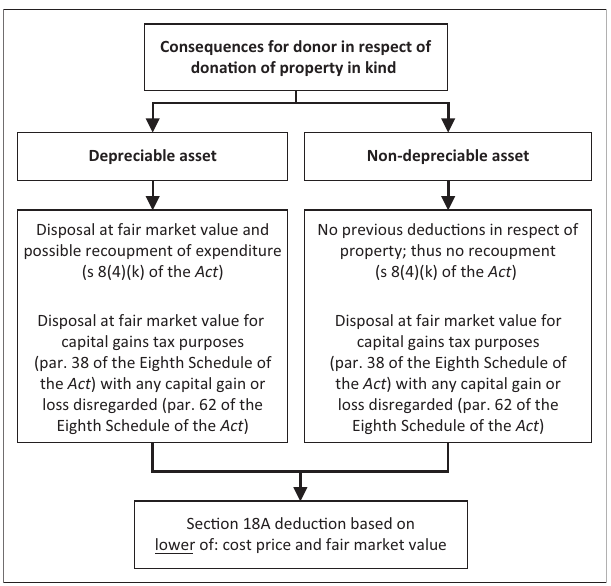
FIG URE 3: Consequences for donor in respect of donation of property in